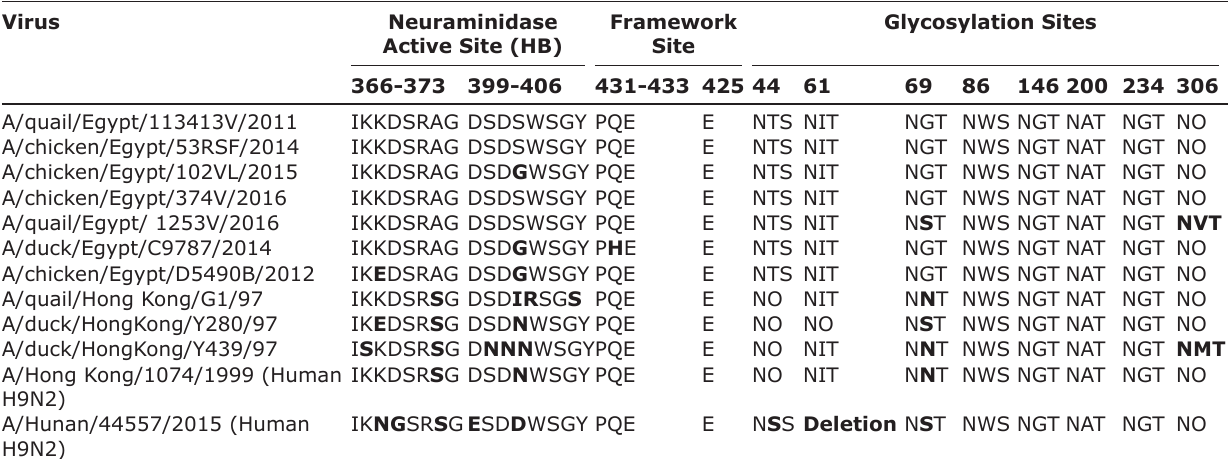
Table-4: Amino acid residues in neuraminidase NA protein .